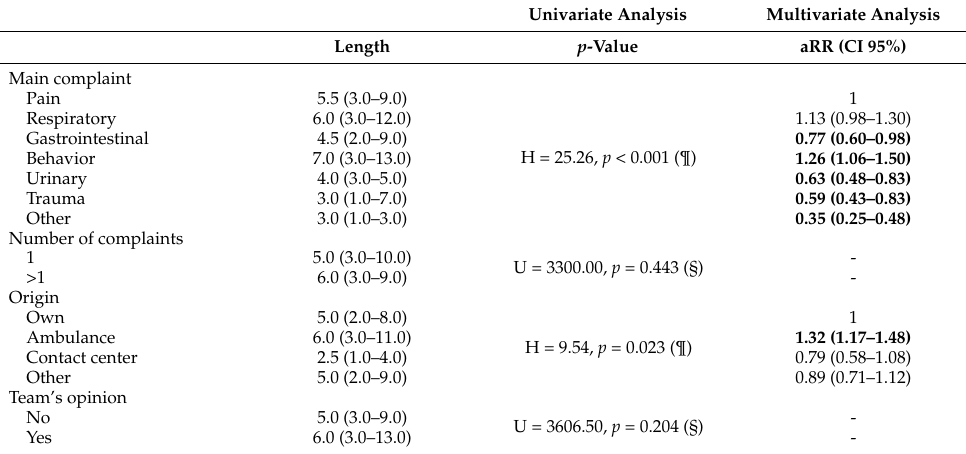
Table 6. Associations with length of stay in the emergency